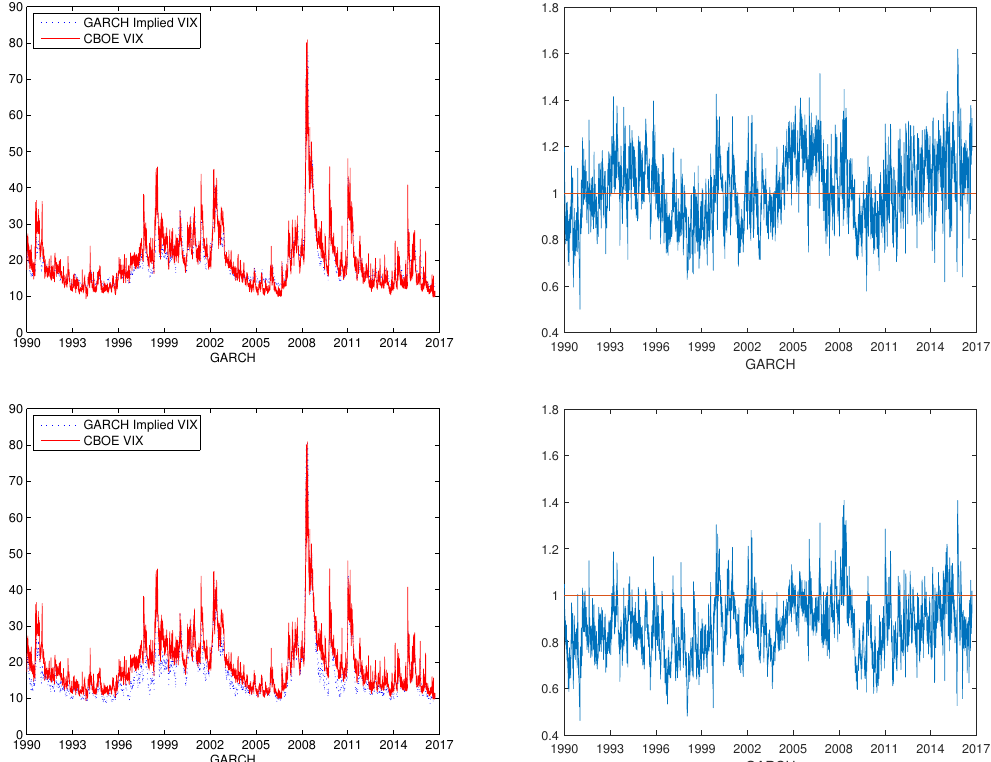
Figure 3. Comparison between CBOE VIX and implied VIX of the GARCH(1,1) model using both returns and VIX data with the upper panels showing the result under the mLRNVR and the lower panels showing the result under the LRNVR. The left panels show the index values of CBOE VIX and implied VIX and the right panels show the ratio of the implied VIX to CBOE VIX and a horizontal line at 1 for